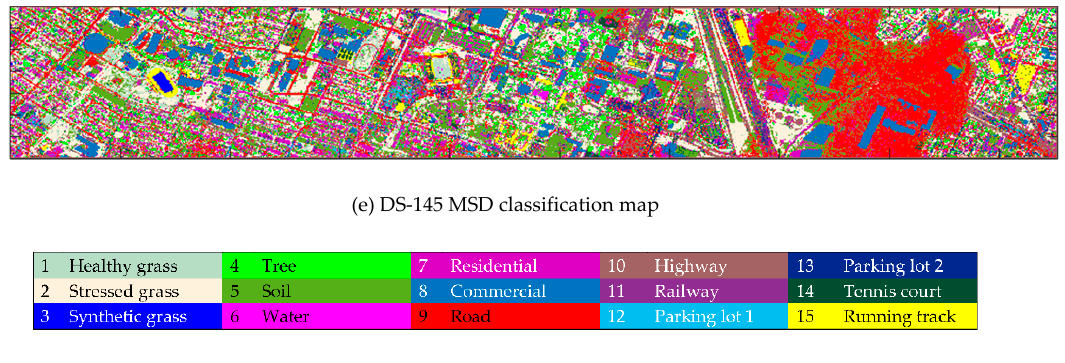
Figure A2. MSD classification maps.